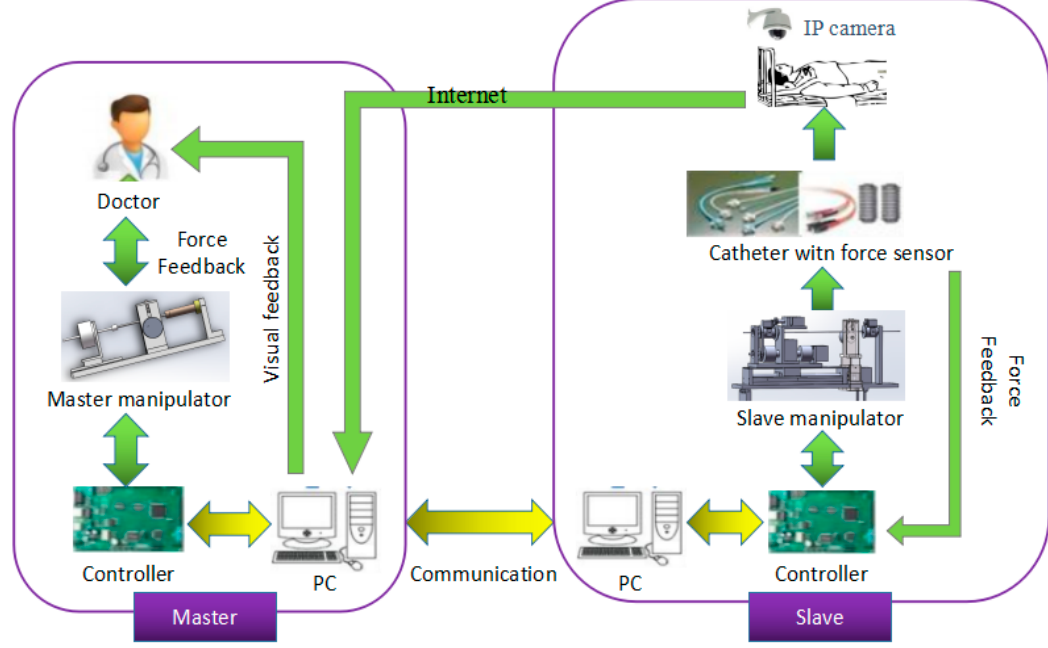
Figure 1. The structure of the master–slave robotic system for vascular intervention surgery.